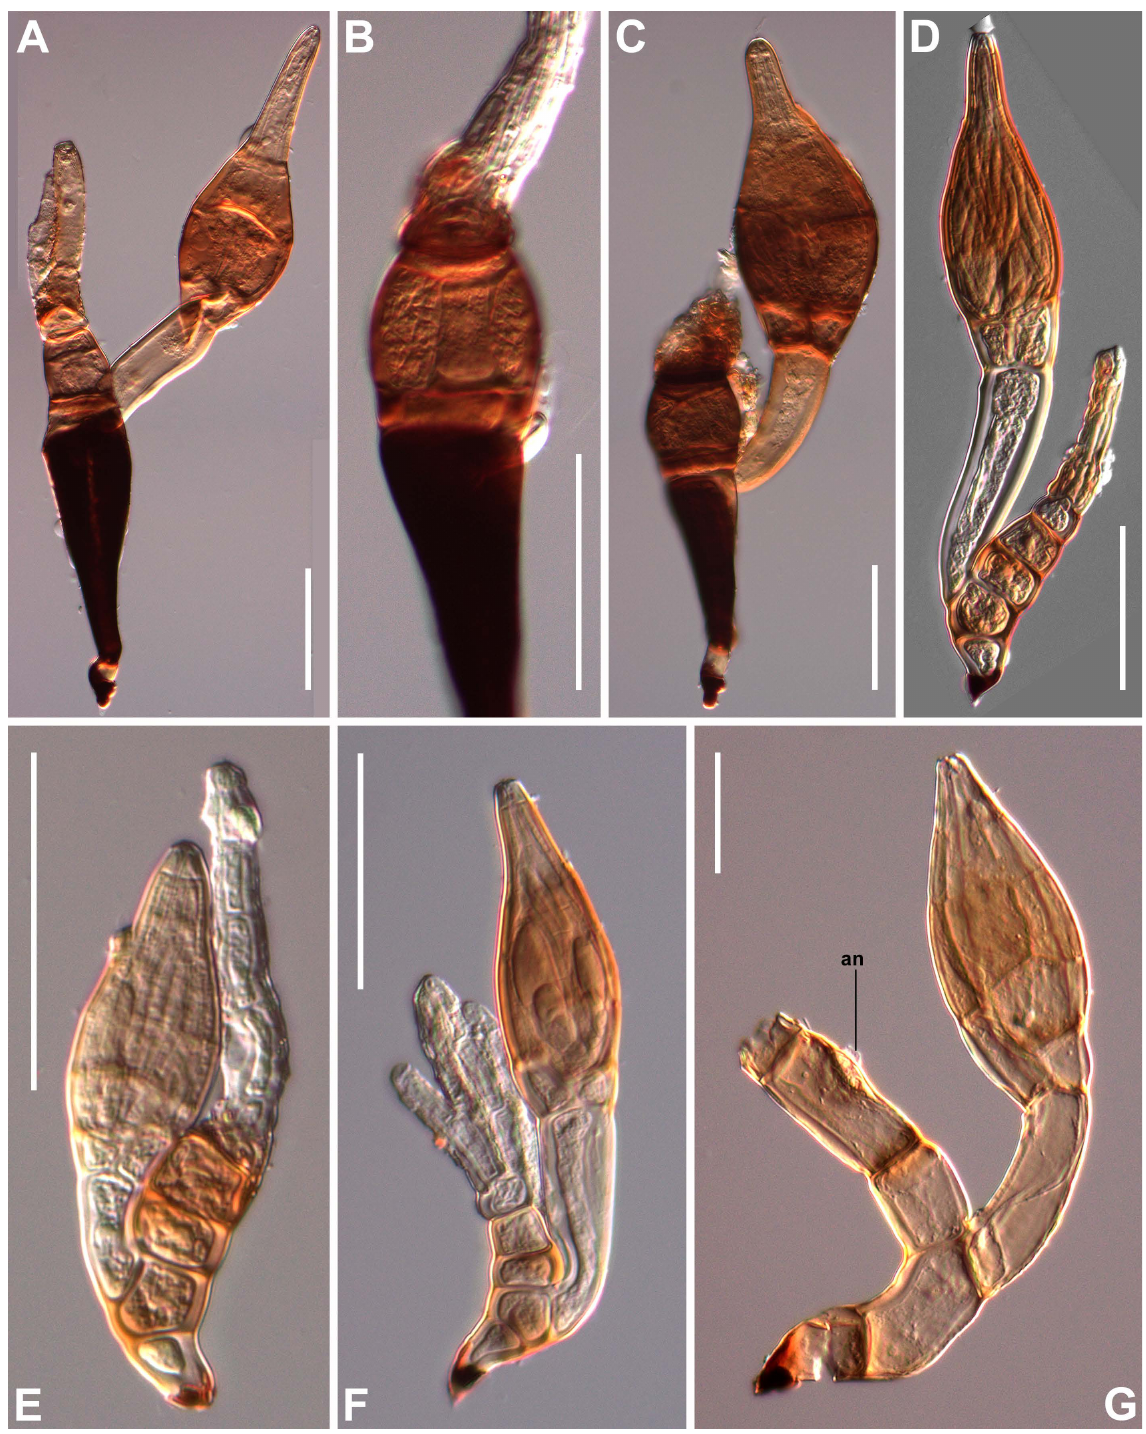
Fig. 77. Cantharomyces spp. A – C . C. numidicus Maire. A , C . Mature thalli. B . Appendage basal cell in detail. – D – F . C. orientalis Speg. Mature thalli. – G . C. platystethi Thaxt. Mature thallus with labelled antheridium (an). Scale bars: 50 µm. Photographs from slides ZMUC C-F-122850 (A), ZMUC C-F- 122935 (B–C), ZMUC C-F-122482 (D), ZMUC C-F-122831 (E), ZMUC C-F-123217 (F), ZMUC C-F- 124182